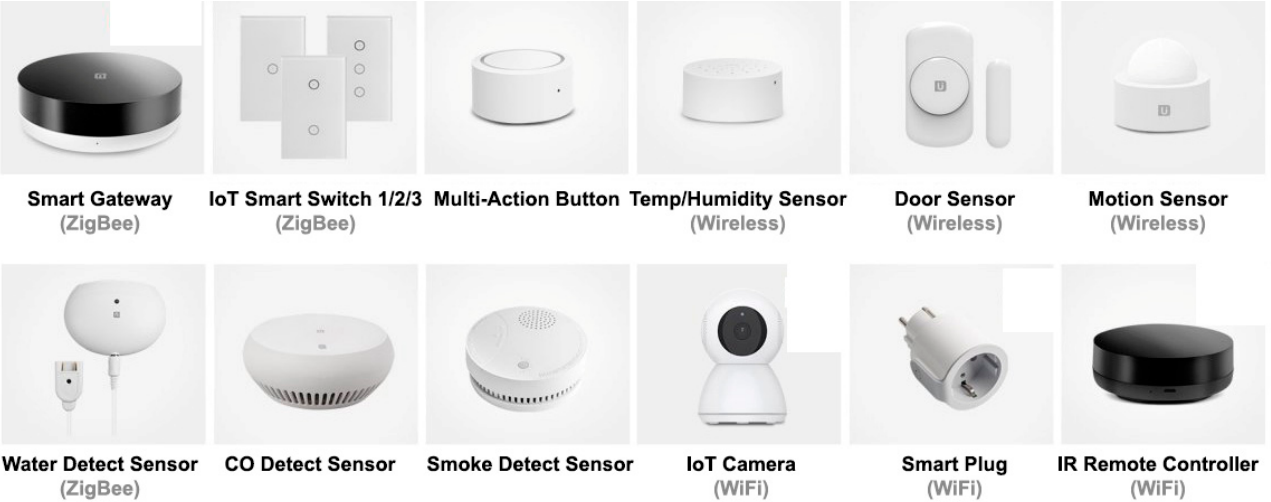
Figure 3. Example of Smart Devices and Sensors for Conventional Home.